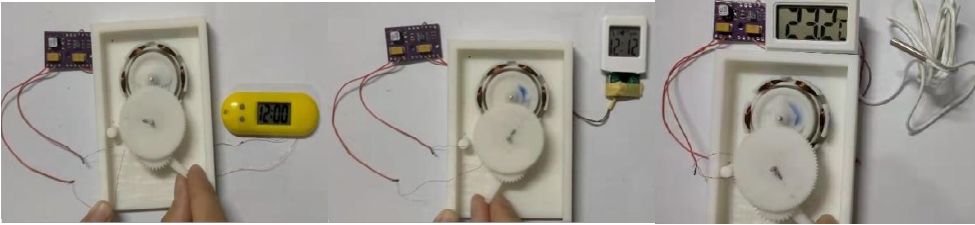
Figure 13. Energy supply experiment of Halbach array to different devices.